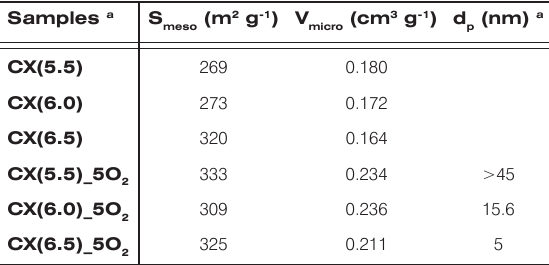
Table 2. Textural properties of the carbon xerogels synthesized at different pH values and those after oxygen activation. Samples